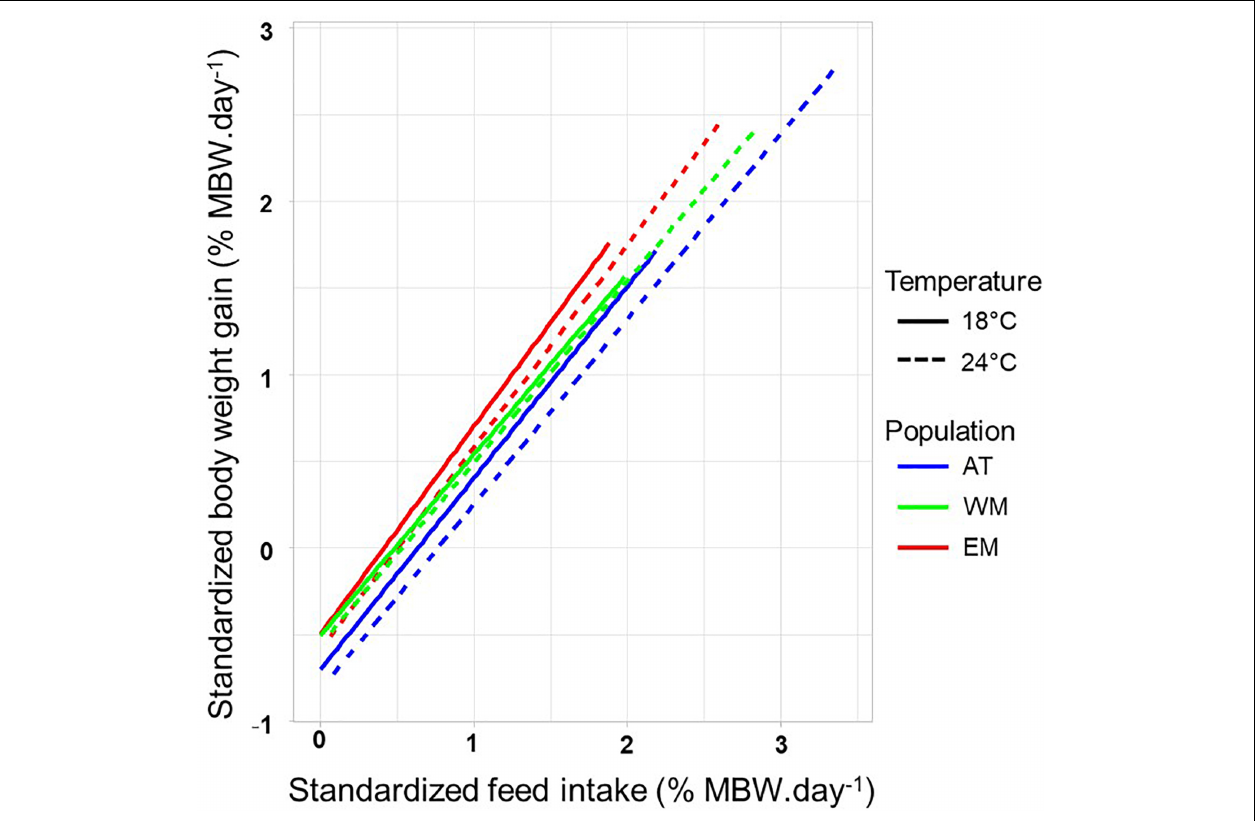
FIGURE 2 | Linear relationships between body weight gain and feed intake, standardized to metabolic body weight (MBW), for the different population by temperature combinations. The three populations are from Atlantic Ocean (AT), West Mediterranean sea (WM), and East Mediterranean sea (EM). Standardized body weight gain and feed intake are expressed in % of MBW per